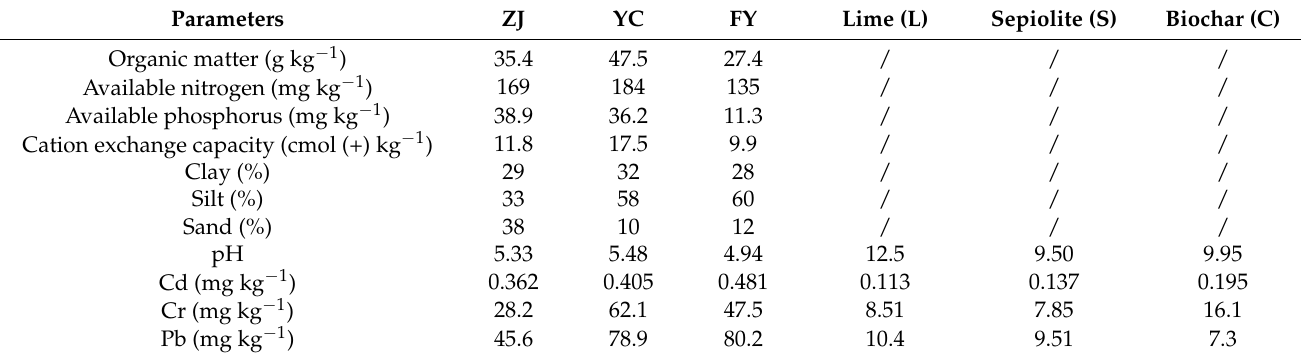
Table 1. Basic properties of soil, lime, sepiolite, and